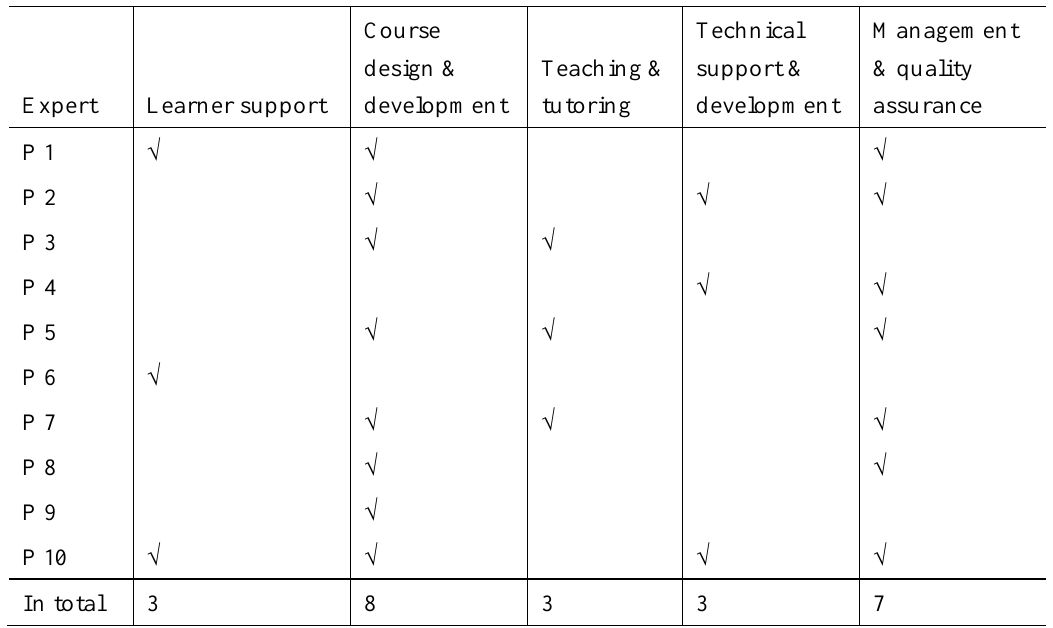
Course development